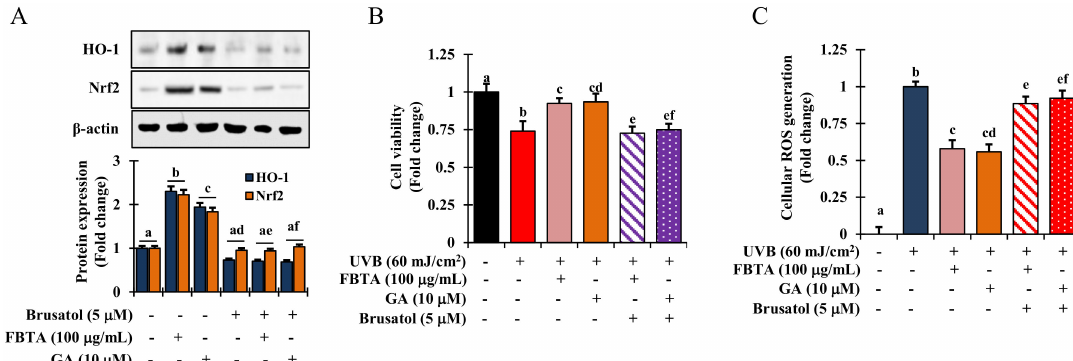
Figure 5. FBTA protects cell death by quenching cellular ROS through activation of Nrf2 .